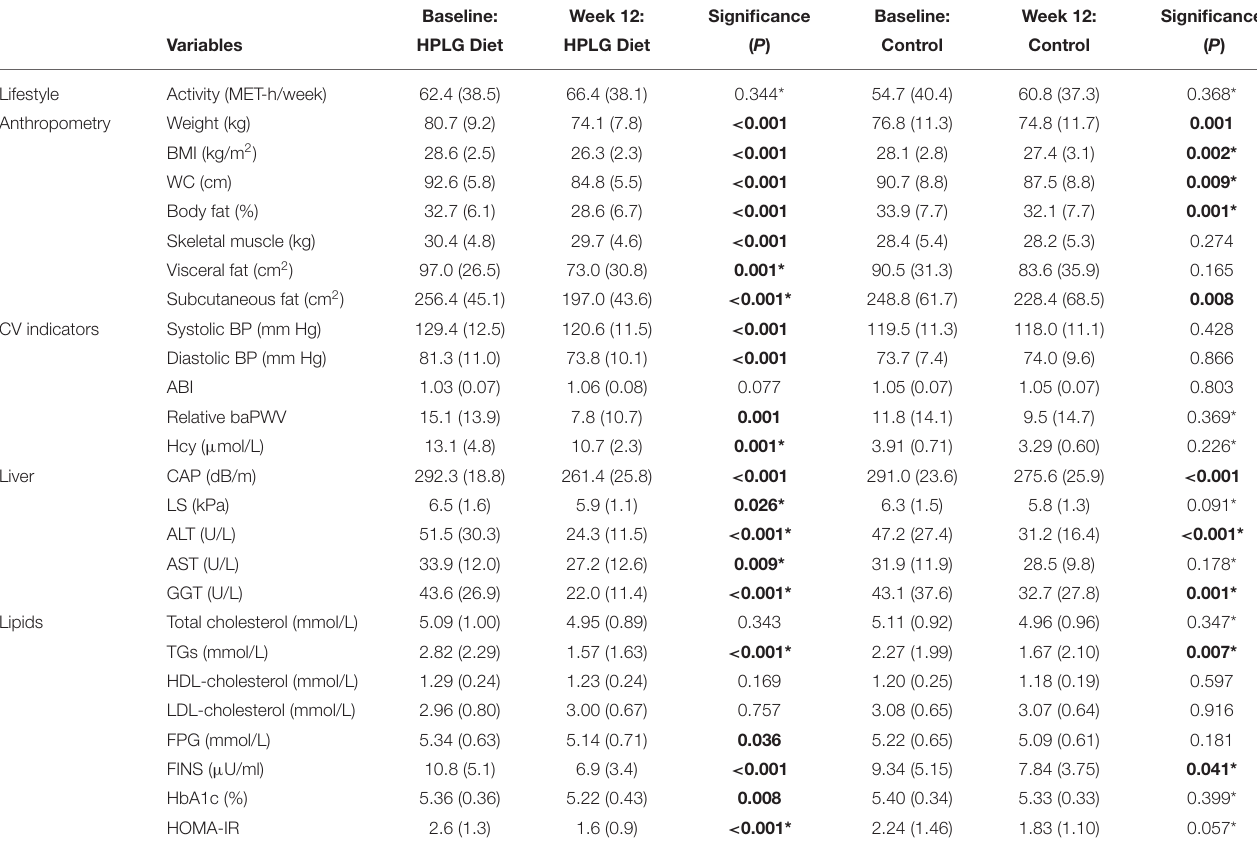
TABLE 4 | Within-group changes from baseline to end of study. Baseline: Week 12: Significance